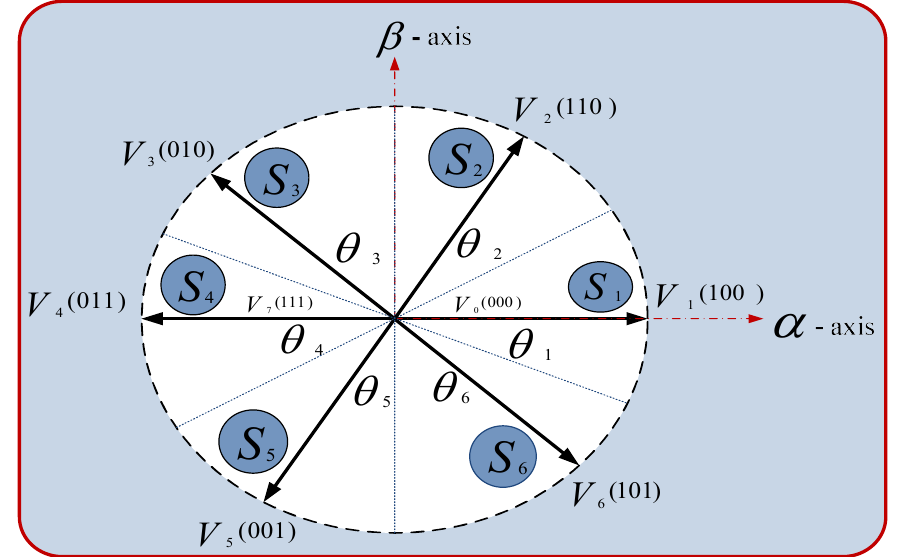
Figure 12. Stator voltage vectors and sectors. Table 2. Inverter switching states. The three-digit numbers in Table 2 describe the switching algorithm where the left- to-right digits give values of S (cid:2911) , S (cid:2912) , and S (cid:2913) , respectively. It shows the switching states for regulating the amplitude and orientation of the stator flux.